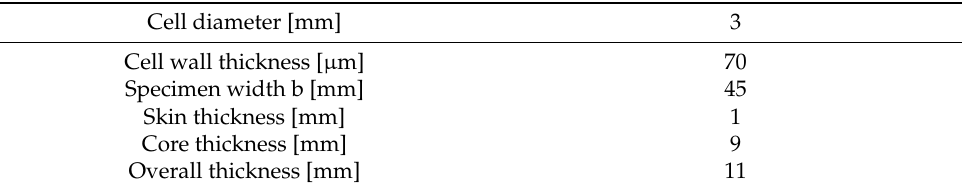
Table 2. Features of tested AHS specimens.